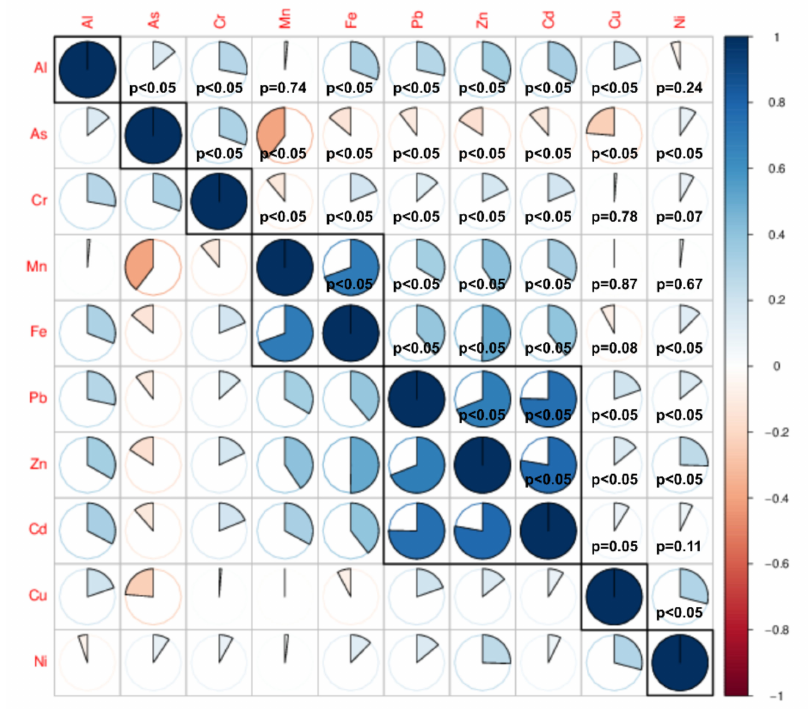
Figure 3. Correlations between heavy metals in tap water. Correlation is statistically significant when the p -value is equal to or lower than